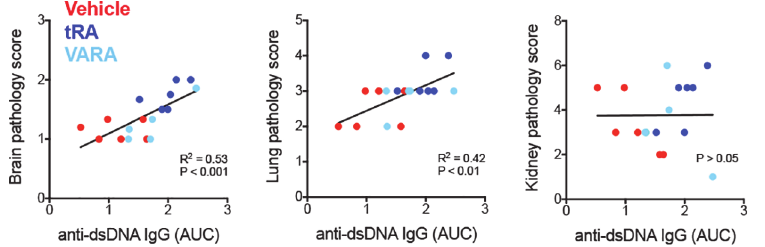
Fig 6. Correlation analysis between blood autoantibody levels and pathological scores. The area under the curve (AUC) was calculated for the level of anti-dsDNA IgG in the circulation and plotted against pathological scores of the brain, lung and kidney. Spearman correlation tests were